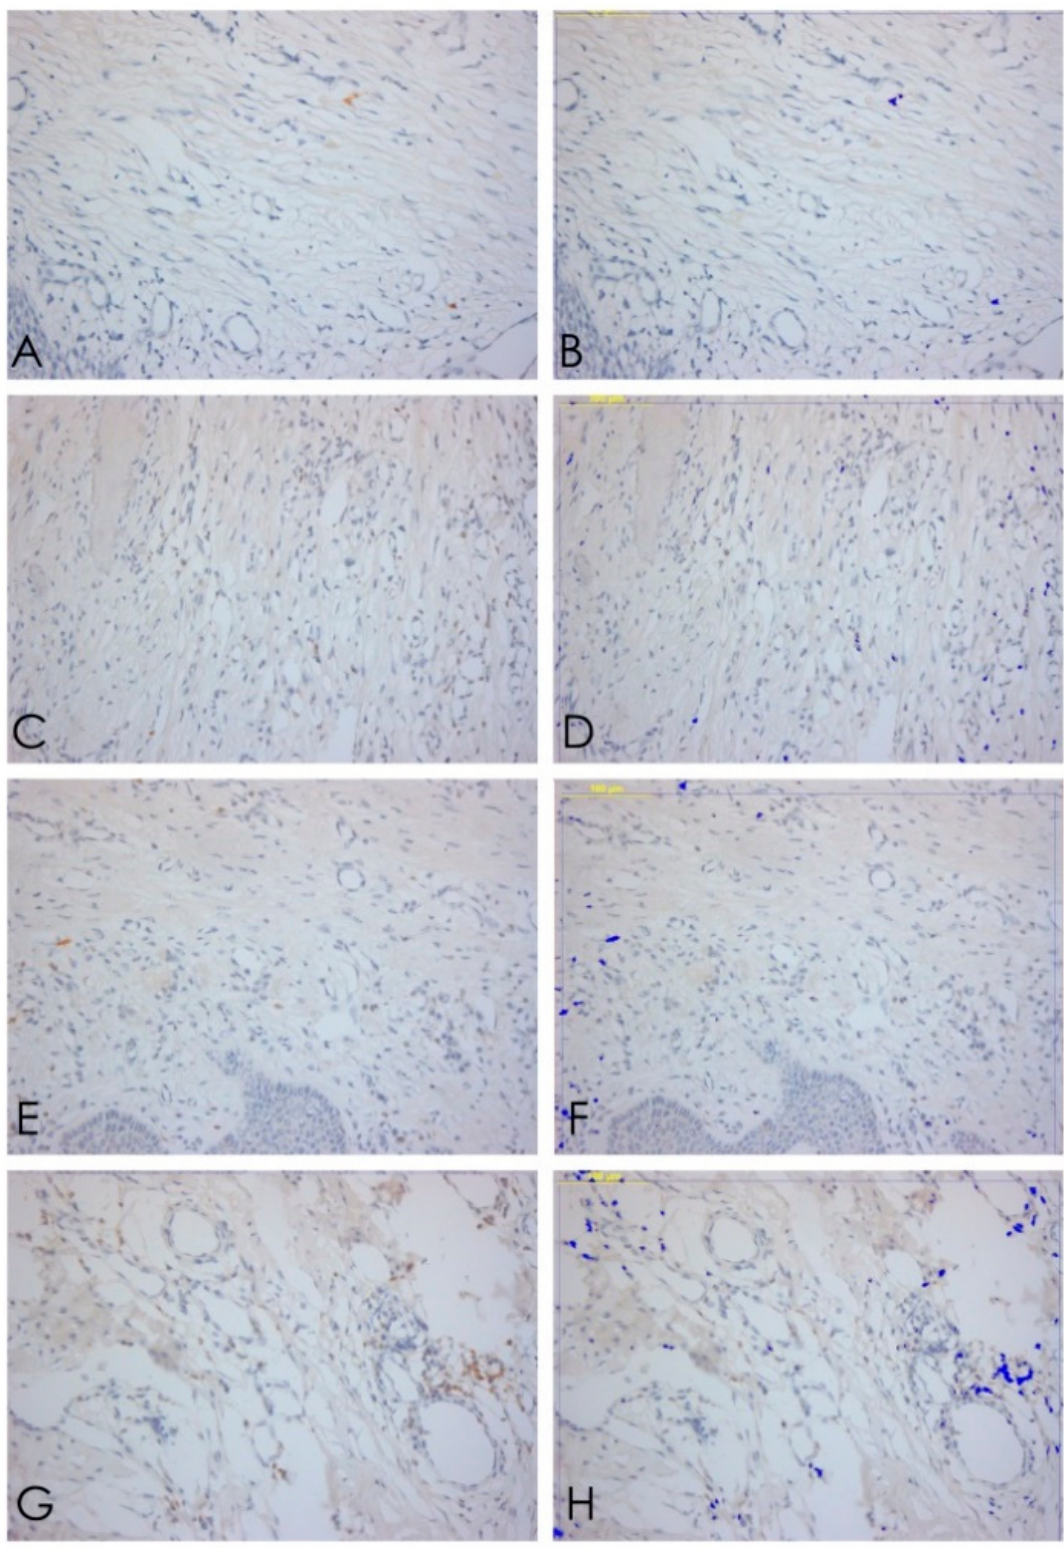
Figure 4. CD3. ( A , B ) T lymphocytes expression T1, 20 × ABC, and software analysis; ( C , D ) T lymphocytes expression T2, 20 × ABC, and software analysis; ( E , F ) T lymphocytes expression T3, 20 × ABC, and software analysis; ( G , H ) T lymphocytes expression T4, 20 × ABC; and software analysis.